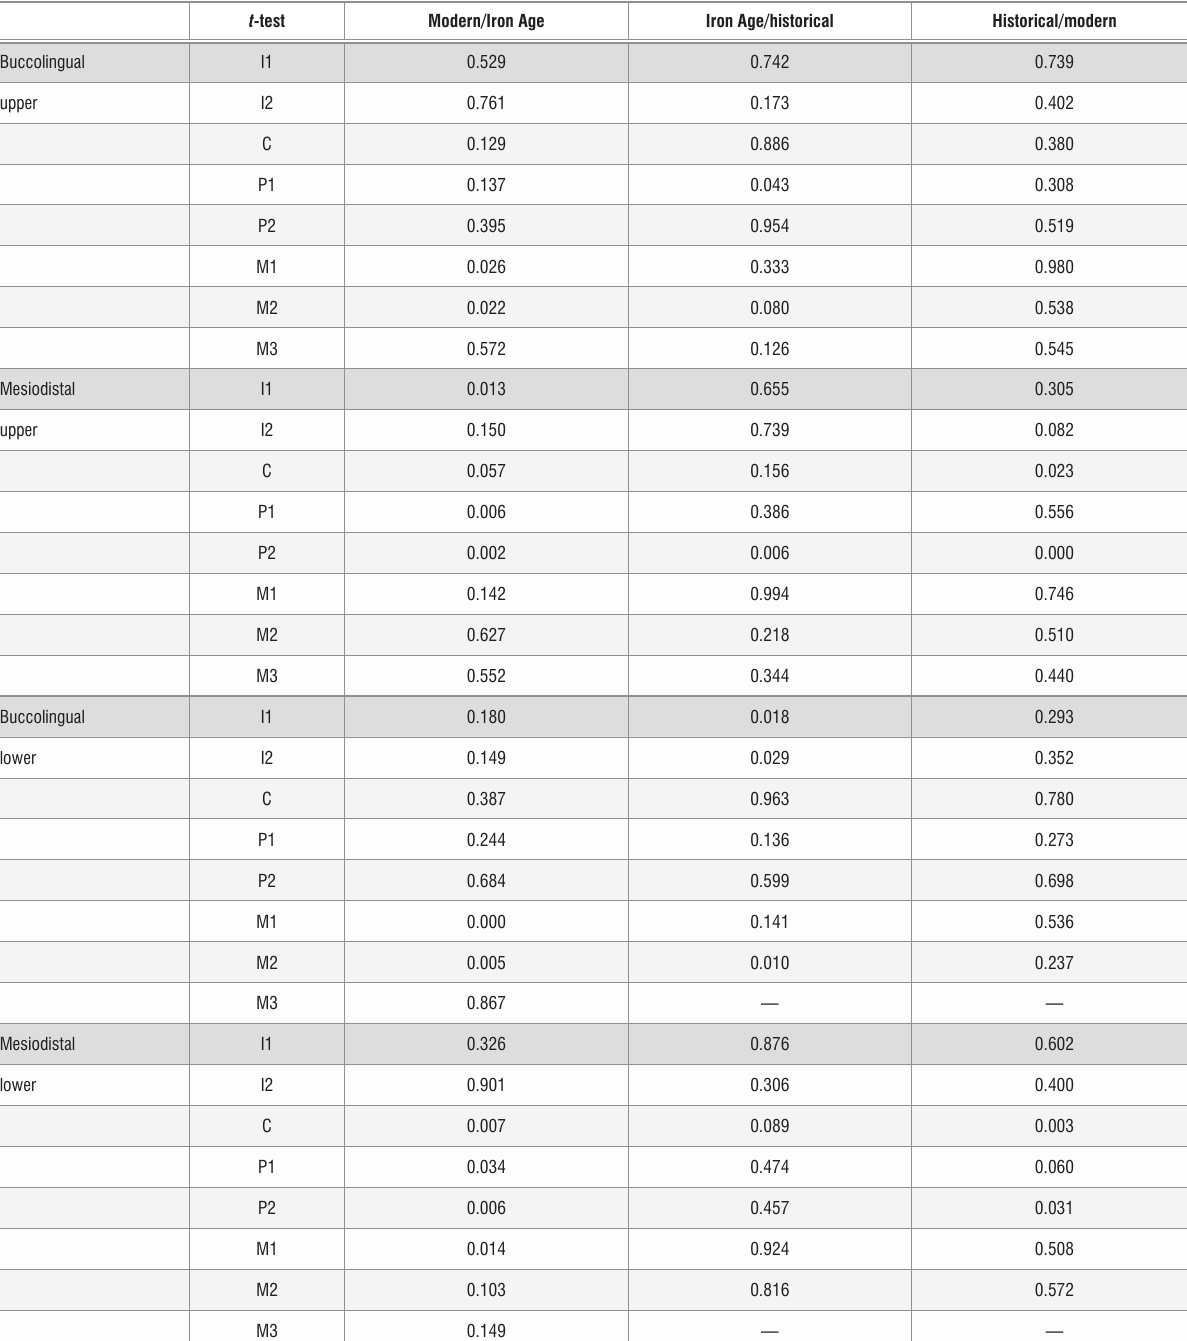
Table 5: The p -values for t -tests for each dental metric